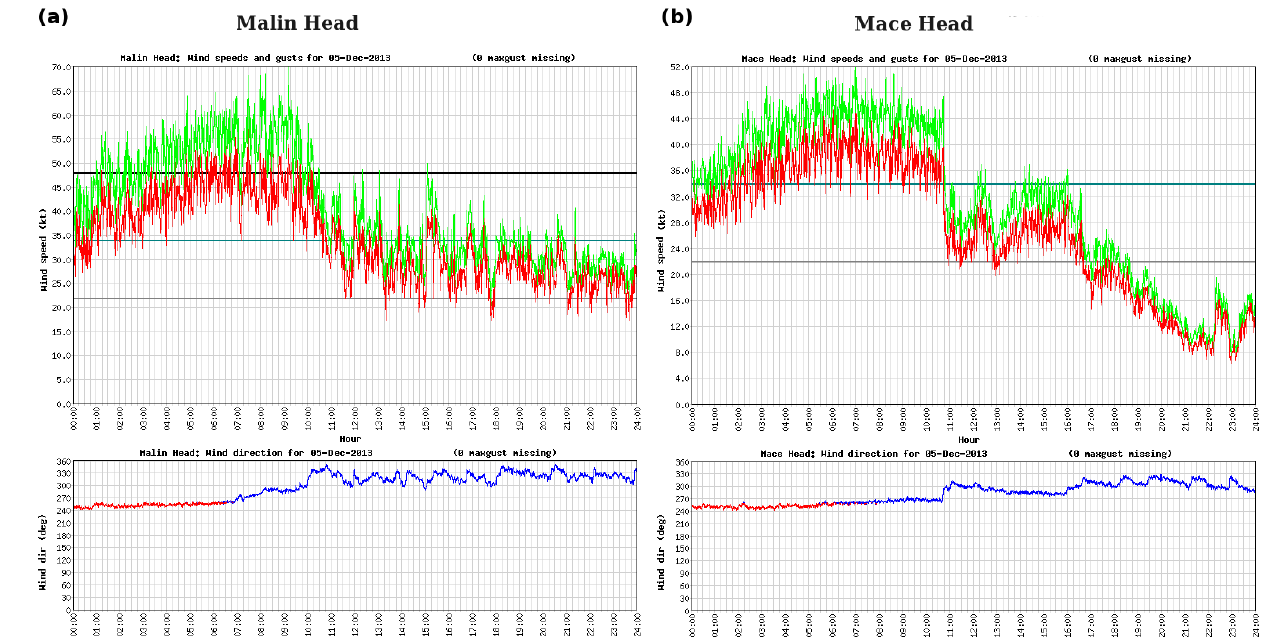
Figure 6. Observations from Met Éireann Synoptic (TUCSON) stations at (a) Malin Head and (b) Mace Head for wind speeds and gusts (top panels) and direction (bottom panels) on 5 December 2013. Top panels: Red = wind speed (kt); Green = wind gust (kt). For context, horizontal lines show mean speed boundaries on the Beaufort scale. Grey = Force 6 “Strong breeze” (22kt); Turquoise = Force 8 “Gale” (34kt); and Black = Force 10 “Storm” (48kt). Note the different scales for wind speed. Bottom panels: Direction of wind speeds and gusts ( ◦ ).